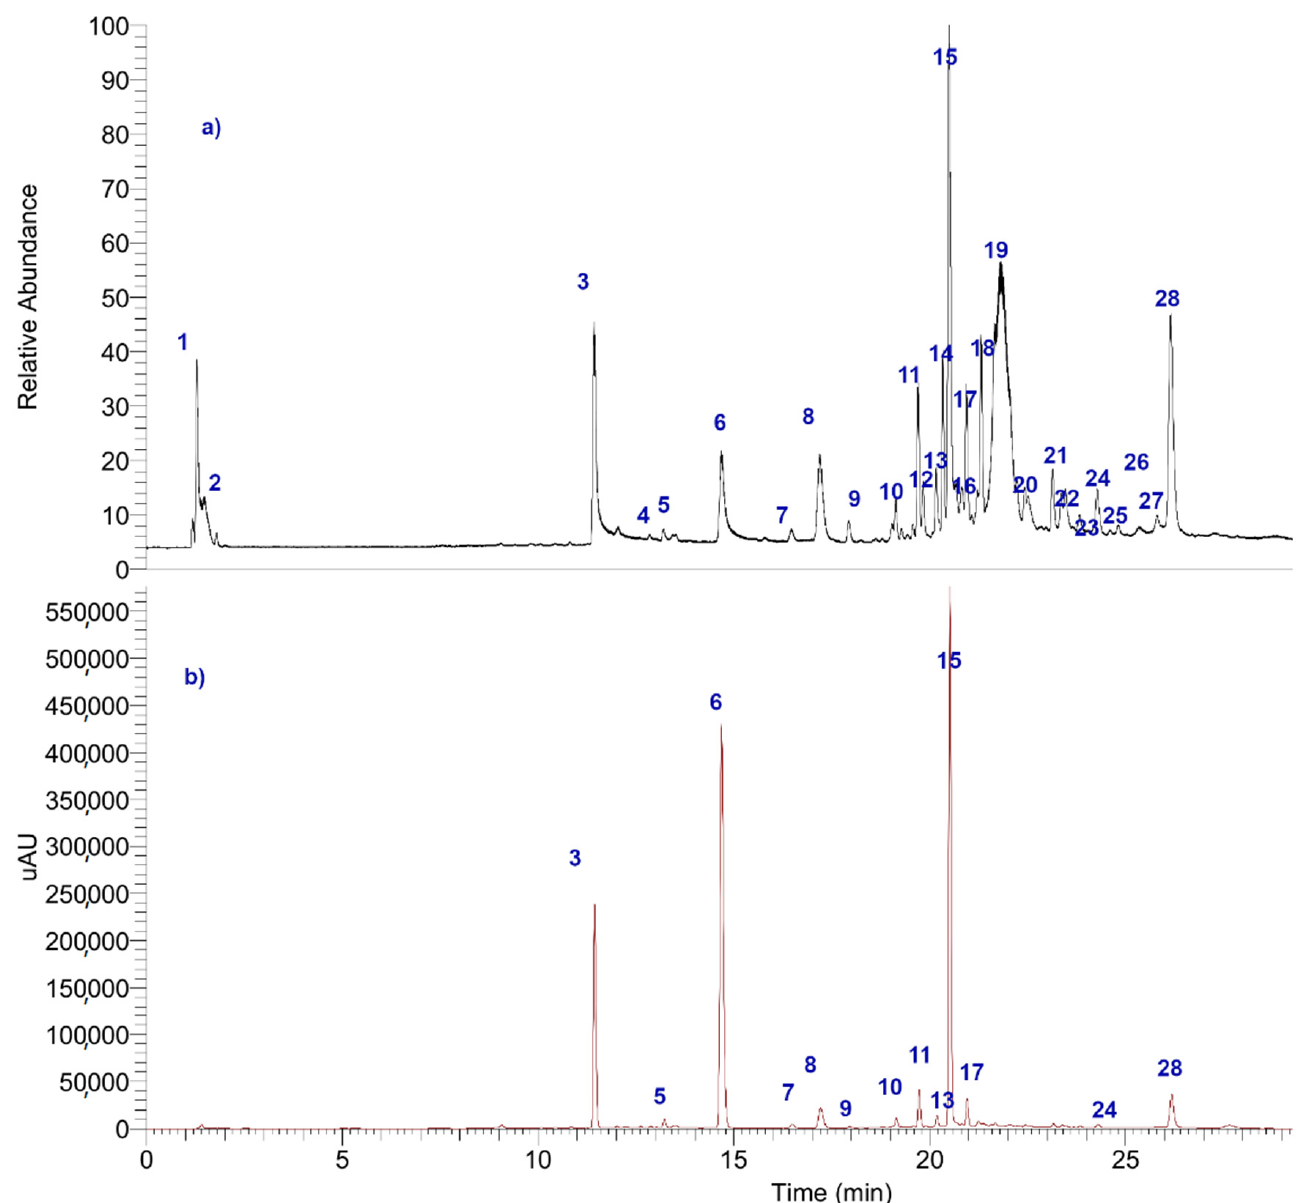
Figure 2. Compounds isolated from H. lugubris (Usnic acid, 1 ; barbatolic acid, 2 ; 5,7-dihydroxy-6- methylphthalide, 3 ; and atranol, 4 ).